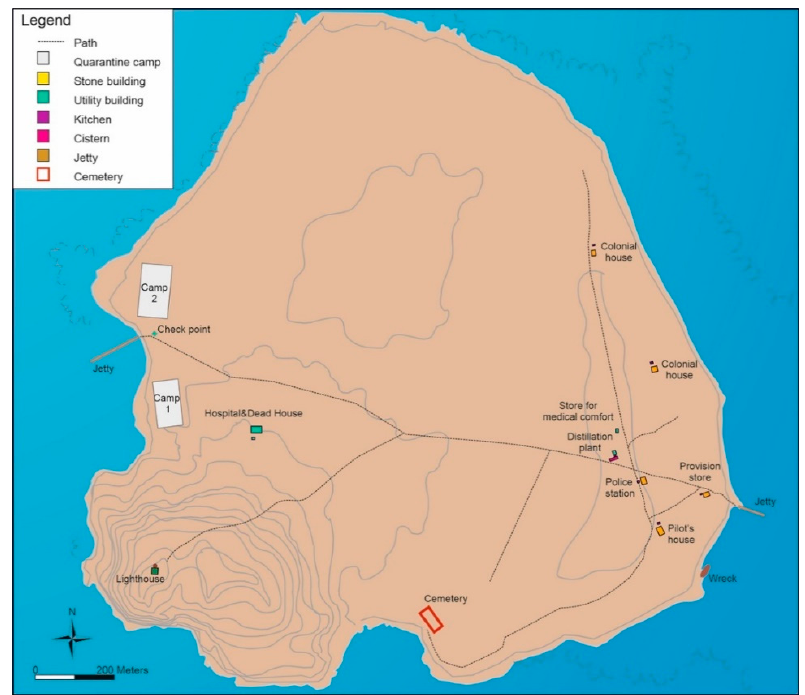
Figure 9. GIS visualization of labeled archaeological features.